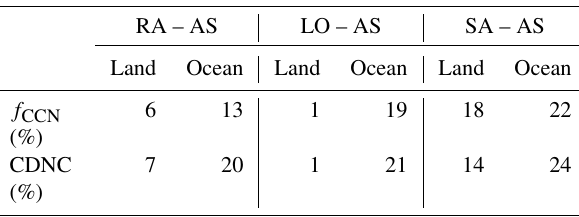
Table 1. Domain-averaged differences ( = sensitivity simulation-AS 100% ) of the CCN activation fraction at 0.6% supersaturation ( f CCN ) and the cloud droplet number concentration (CDNC) in percent. The data are averaged from 00:00UTC on 15 May to 00:00UTC on 15